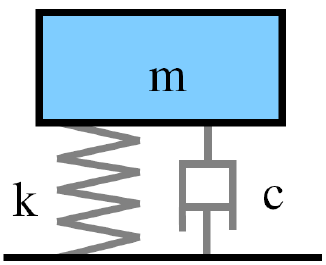
Figure 3. Single-degree-of-freedom system [56].